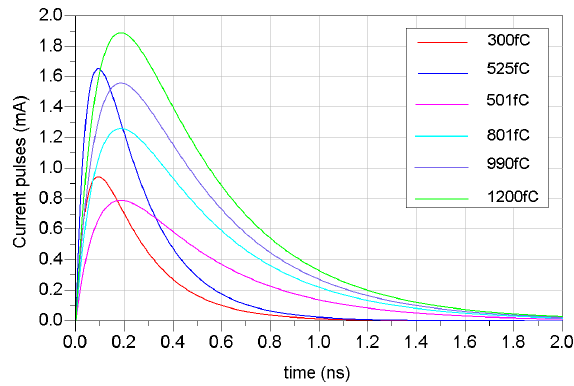
Figure 4. Current pulse shapes used for single event transient (SET)